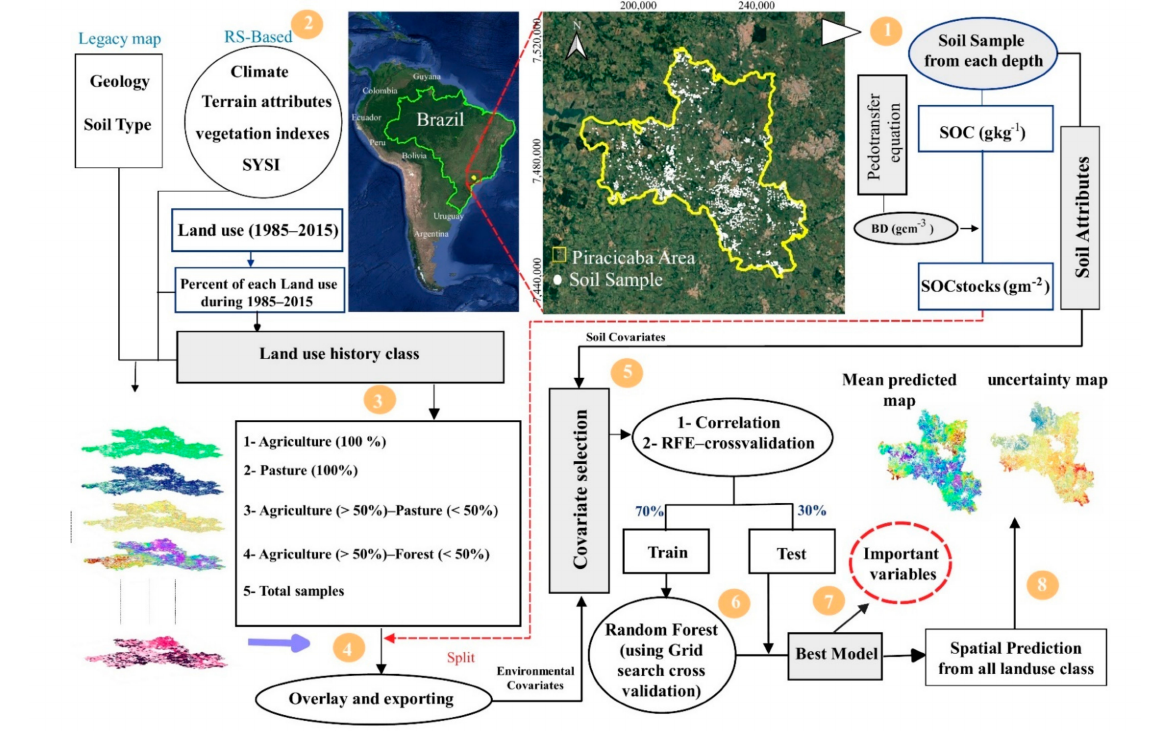
Figure 1. Flowchart showing the location and the methodology applied for this